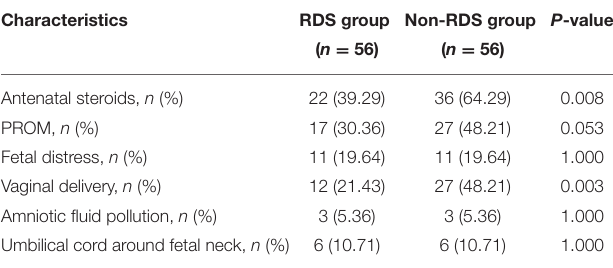
TABLE 3 | Perinatal characteristics of 112 preterm infants.